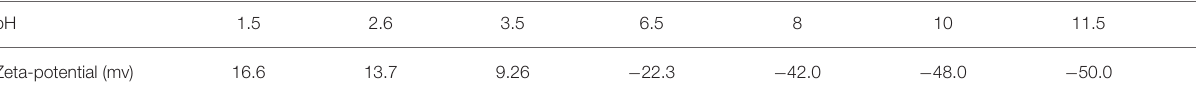
TABLE 4 | Zeta-potential of MK dispersion under various pH in solution with MK/water ratio of 1,500.